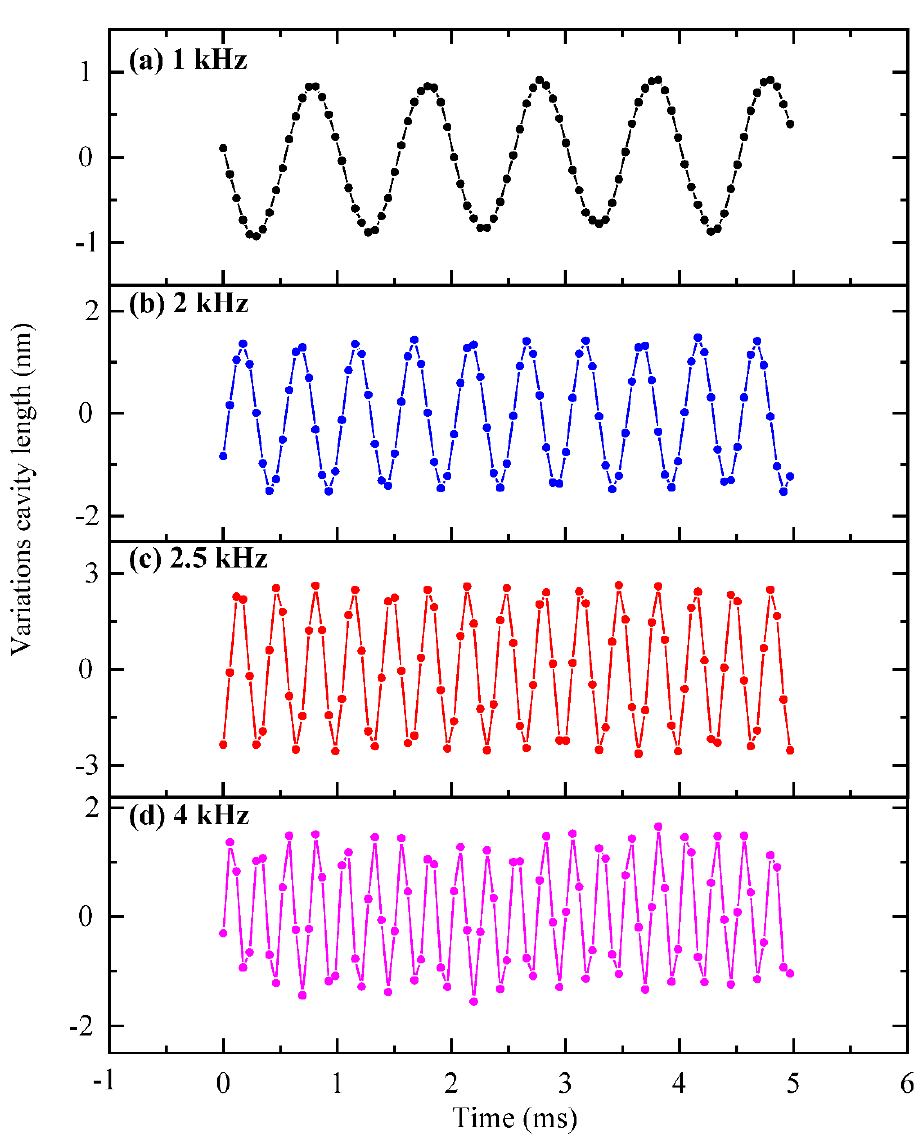
Figure 6. Time-domain responses of the FOM under 0.003 Pa radial acoustic pressure of ( a ) 1 kHz, ( b ) 2 kHz, ( c ) 2.5 kHz, and ( d ) 4 kHz.